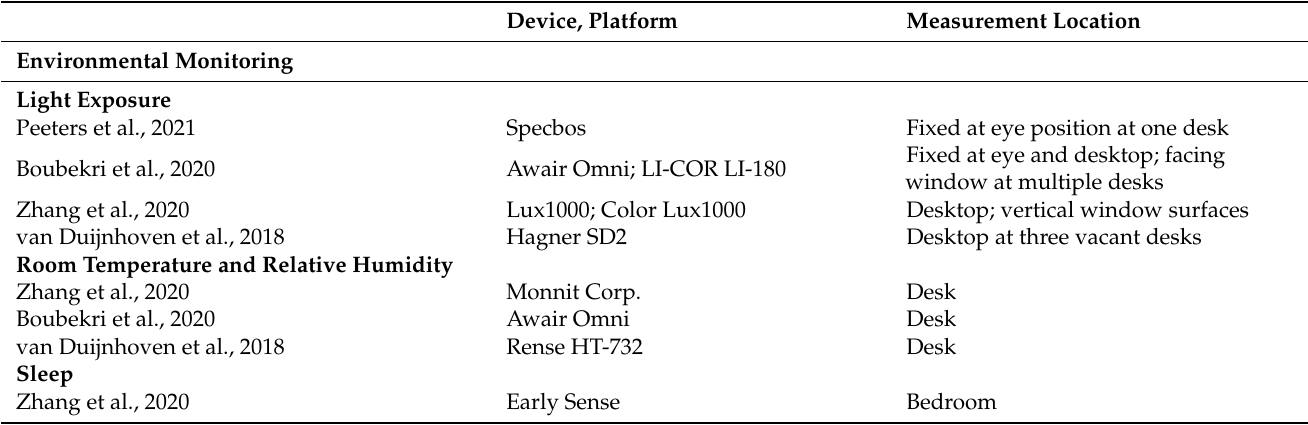
Table 4. Data collection devices used in previous studies [1–4,6–12]. Environmental data was collected continuously, when specified, with intervals ranging from 30-s to 5-min. Desktop measurements are horizontal measurements, and window and eye position measurements are in the vertical plane. It is assumed measurements were taken at every desktop unless otherwise